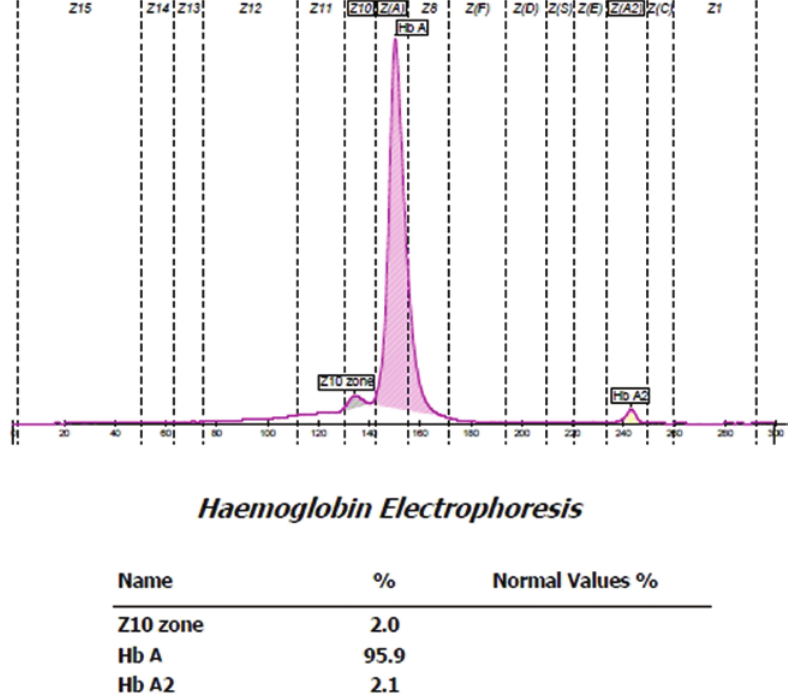
Figure 1: Capillarys Hemoglobin(E) Electrophoresis chromatogram showing the zone 10 peak of 2.0% eluting just before HbA